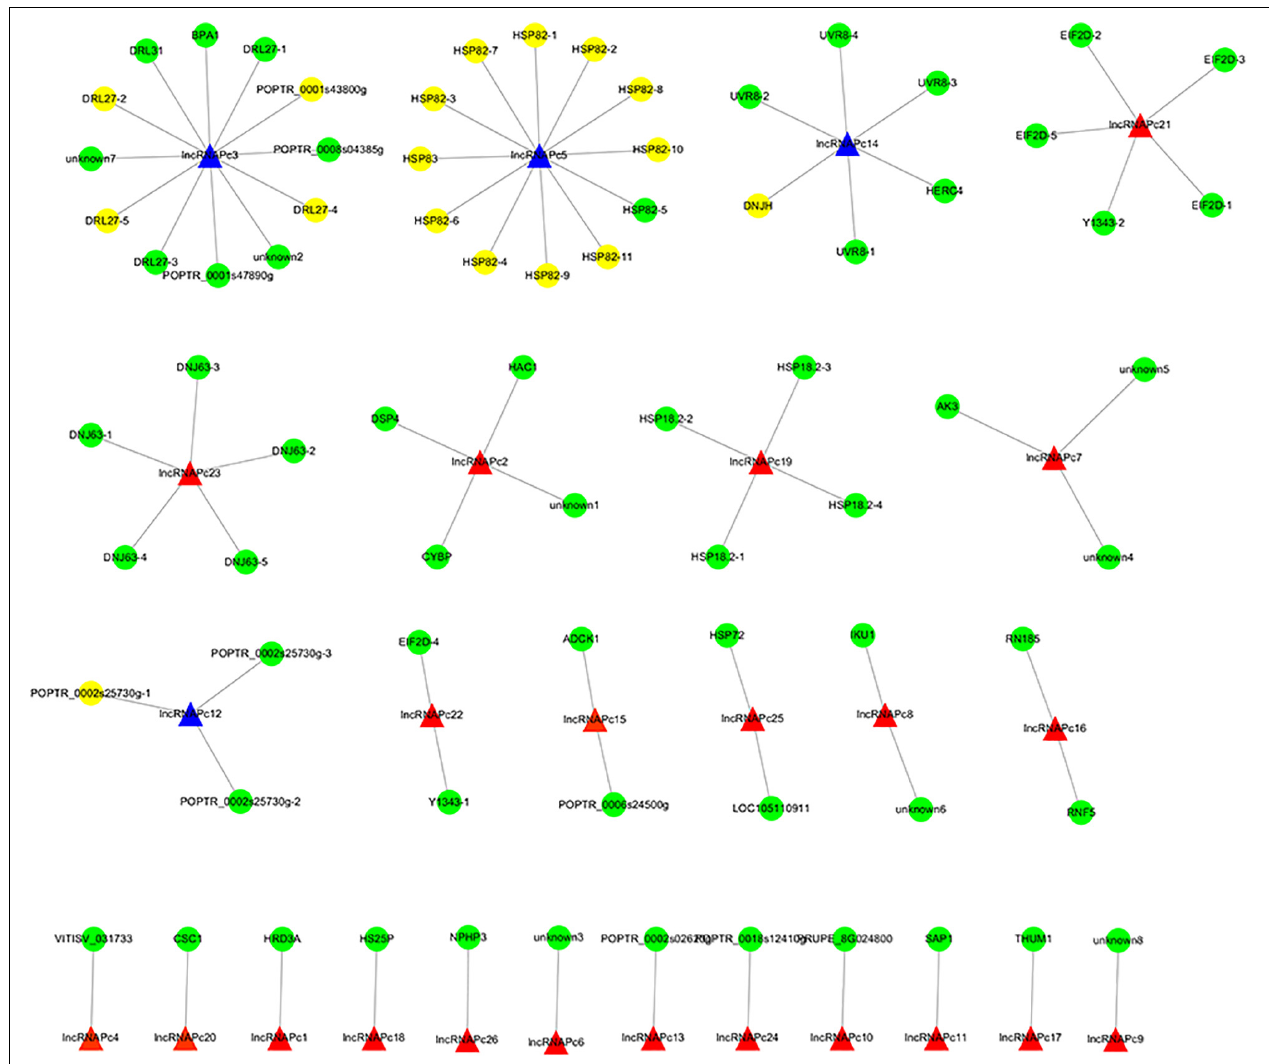
FIGURE 5 | The lncRNA–gene interaction networks. The blue triangle is the candidate lncRNA and the yellow circle is the genes.